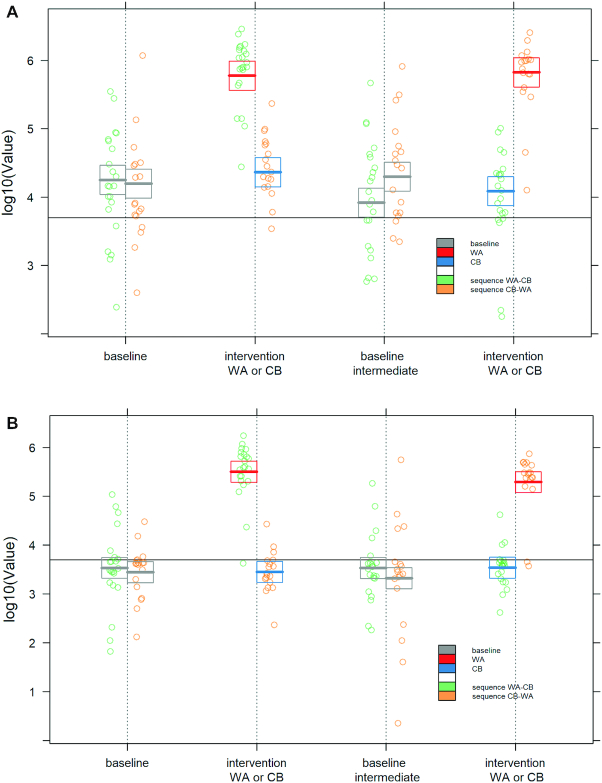
Measured values of urinary phloretin glucuronide (A) and phloretin glucuronide sulfate (B) for each visit, for both the treatments. Dots are individual values. Vertical dotted lines intersecting the x axis represent each visit; sequence WA–CB is plotted to the left of the vertical dotted lines and sequence CB–WA to the right of them. The boxplots represent the mean values and the 95% bootstrap CIs as computed by the mixed linear models of treatment effect. Red: estimates corresponding to WA intake; blue: estimates corresponding to CB intake; gray: estimates corresponding to both baselines (initial and intermediate). CB, control beverage; WA, whole apple.